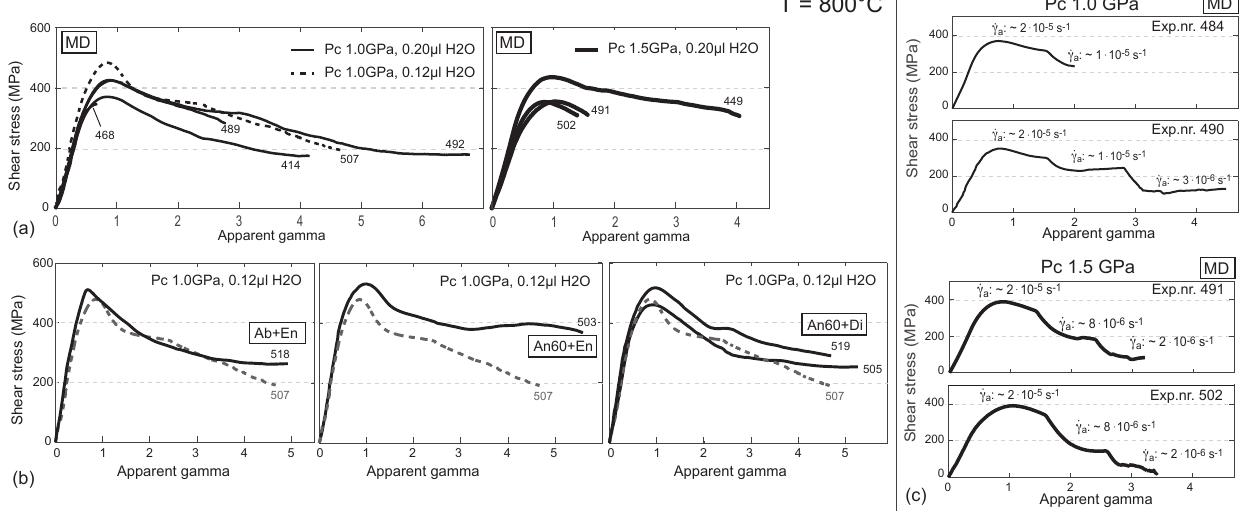
Figure 2. Mechanical data. Shear stress, τ (MPa), versus apparent shear strain, γ a . Stippled line: experiment 507 (MD) for reference. (a) Maryland diabase (MD) experiments for different confining pressures, Pc (GPa), and water contents. (b) Experiments using different Pl–Px mixtures and constant Pc and water content. (c) Displacement rate stepping tests on MD sample material for experiments performed at different confining pressures.